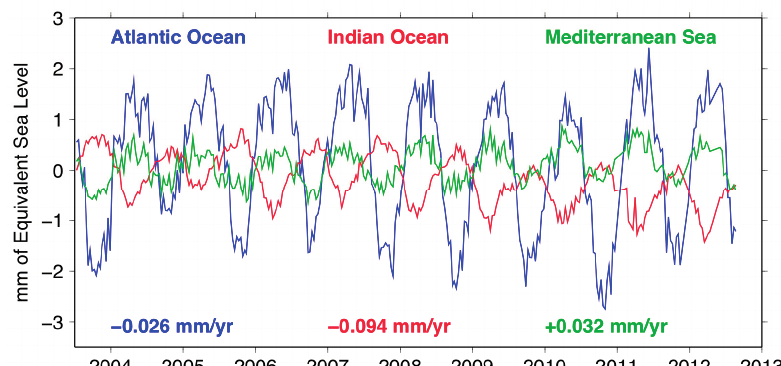
Figure 11. Time series of the main African river basins contributions to the Atlantic and Indian oceans, as well as to the Mediterranean Sea, expressed in mm of